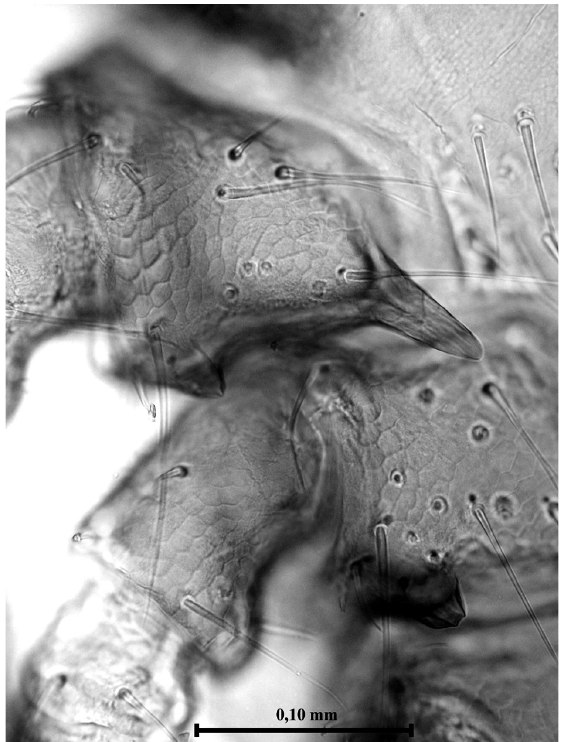
Fig. 6. – Particular of figure 4: external thorns of the coxae III and IV of the male of Ixodes festai. The terminal cusps of the external thorns are well visible.